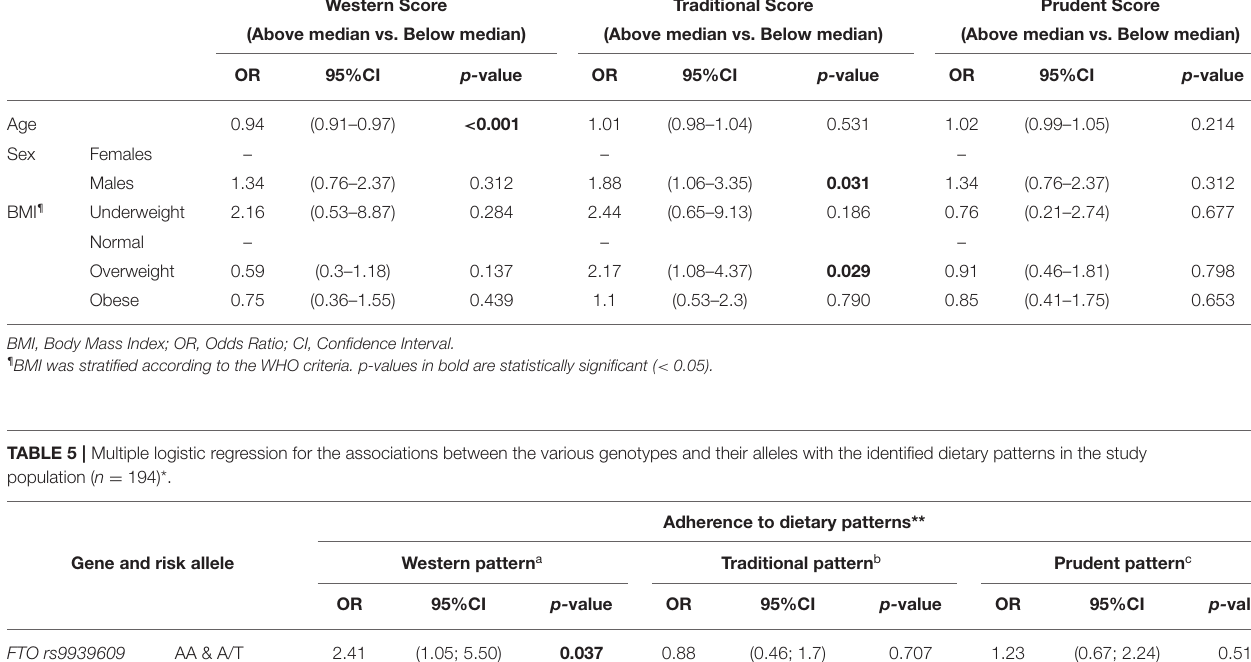
TABLE 4 | Association of age, sex, and BMI with the identified dietary patterns in the study population ( n = 194). Western Score Traditional Score (Above median vs. Below median)